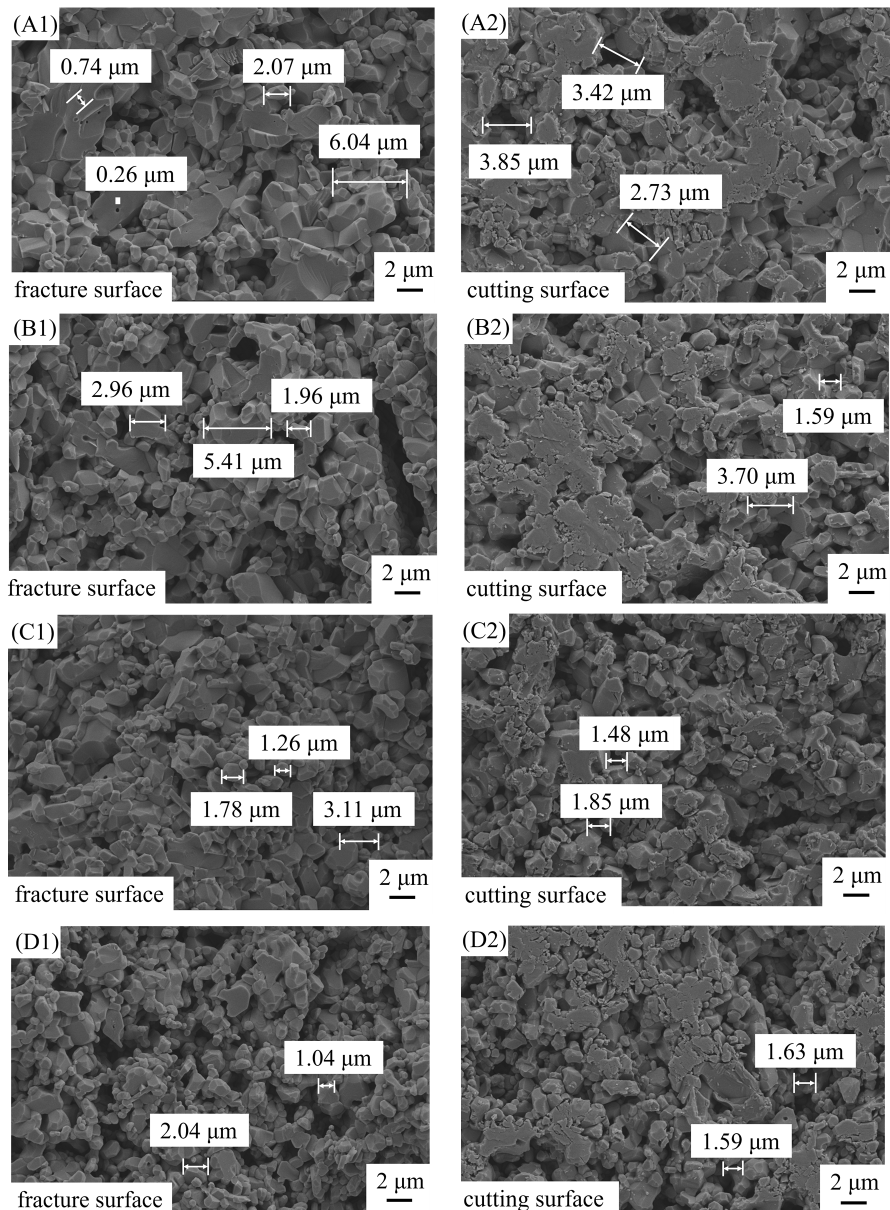
Figure 5. SEM images of the porous alumina prepared using different pore-forming agents. Agent contents: ( A1 , A2 ) 20 vol.% pore-forming agents + 80 vol.% alumina; ( B1 , B2 ) 30 vol.% pore-forming agents + 70 vol.% alumina; ( C1 , C2 ) 40 vol.% pore-forming agents + 60 vol.% alumina; ( D1 , D2 ) 50 vol.% pore-forming agents + 50 vol.% alumina.